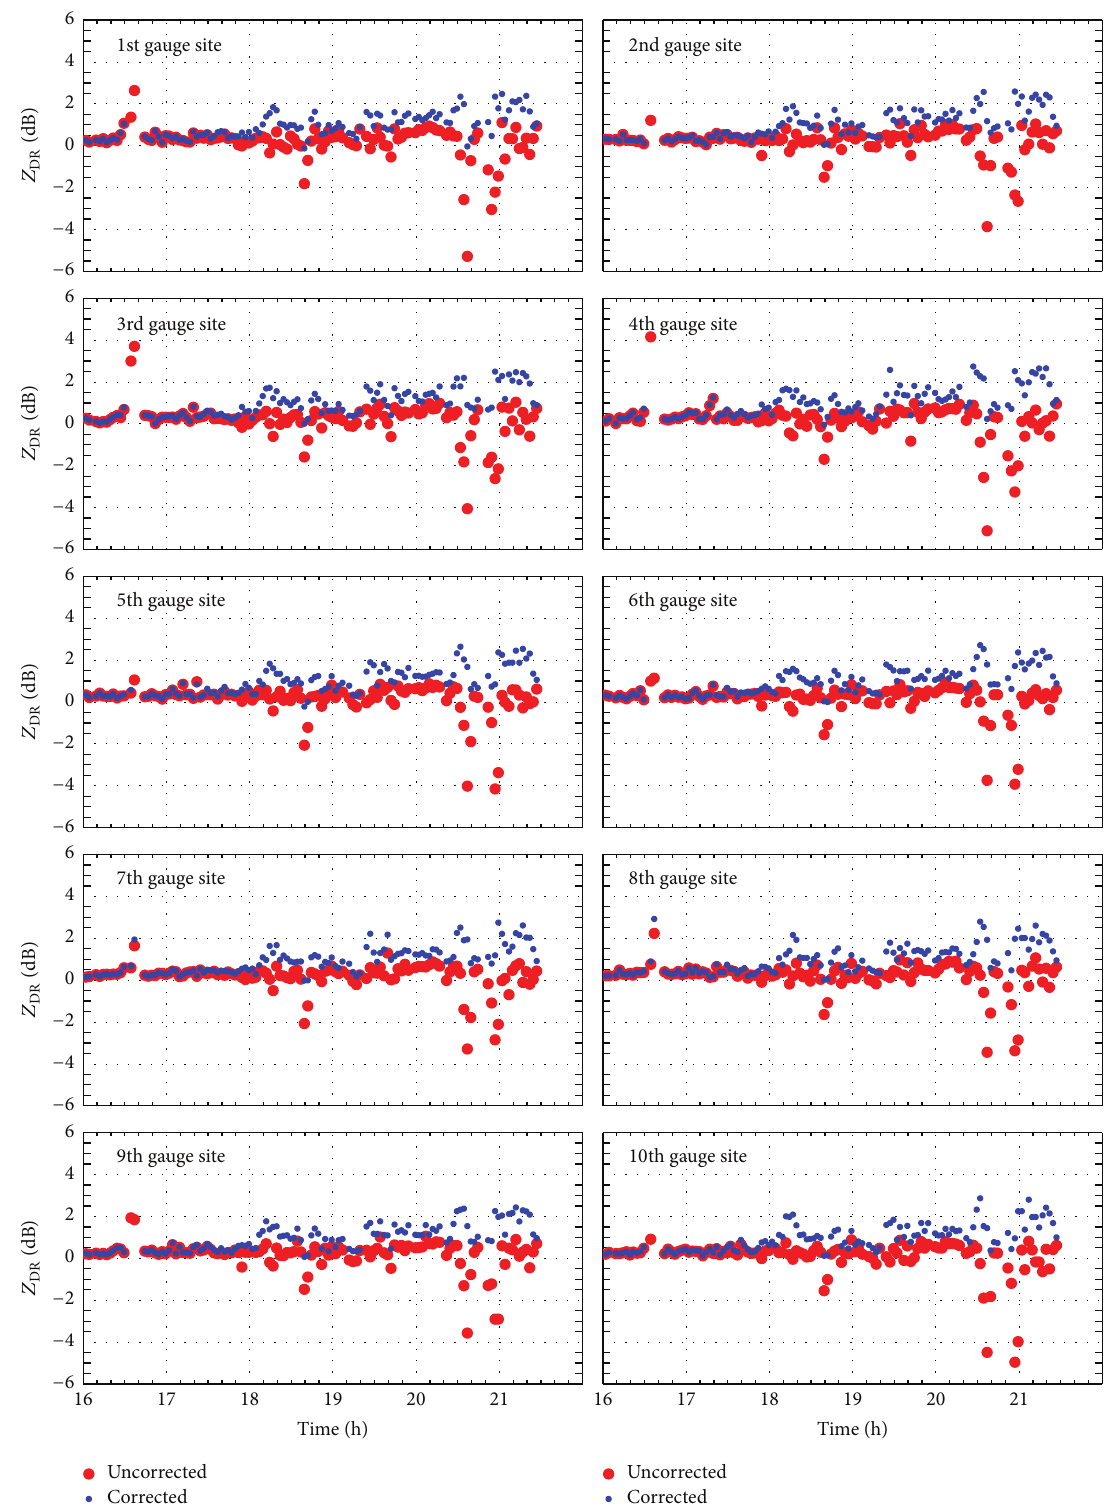
Figure 12: Time series of measured (red circle) and attenuation corrected (blue circle) 𝑍